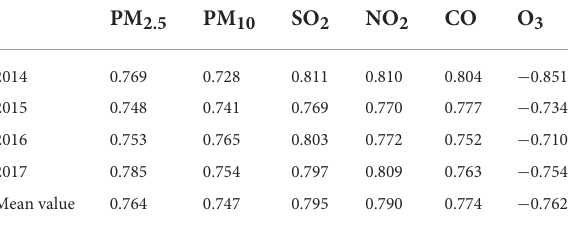
TABLE 3 Median correlation coefficients between the influenza incidence and air pollutants in China’s prefecture-level cities during the period